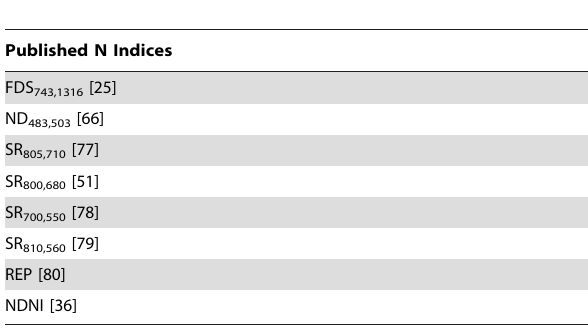
Table 1. Previously identified relationships between leaf N concentration and hyperspectral vegetation